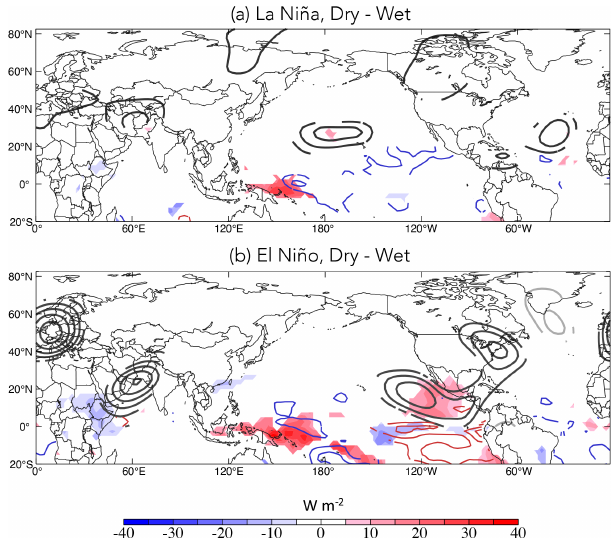
Figure 12. Composite difference, dry − wet, during (a) La Niña conditions (Fig. 11a–b) and (b) El Niño conditions (Fig. 11c–d). Plotting conventions are as in Fig. 11, except the contour interval for SST anomalies (blue and red contours) is 0.25 ◦ C.